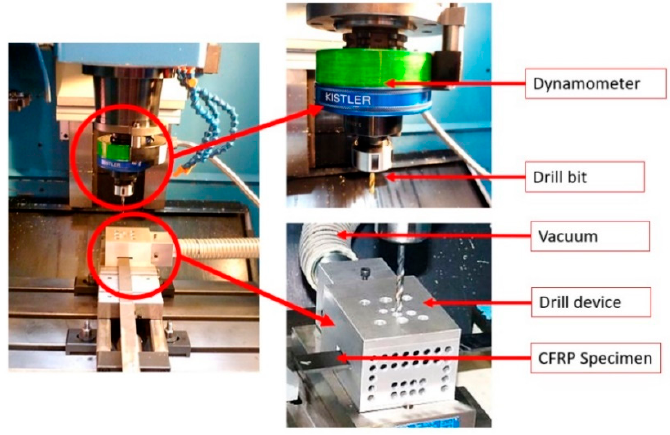
Figure 1. Experimental set-up device.